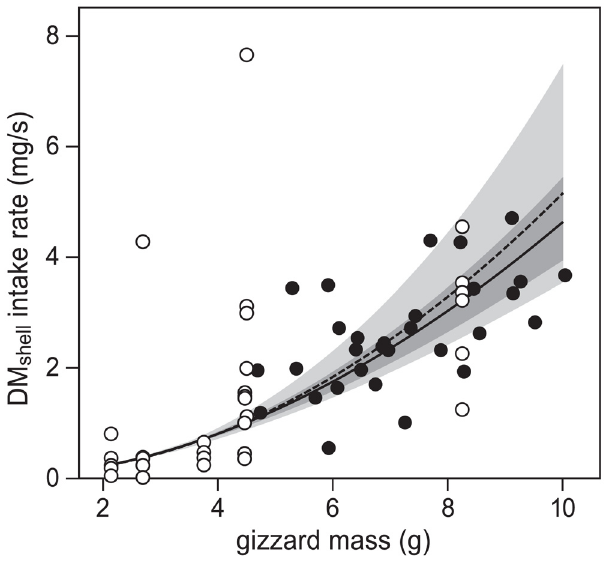
Fig 3. Regression of DM shell intake on non-toxic prey against gizzard mass. Data from this study on Dosinia was combined with data from van Gils et al . [14] on other non-toxic prey species. Adding the current data to the regression derived by van Gils et al . [14] slightly changes the regression line (though not significantly; from dashed to solid line), but greatly reduces standard error (from light to dark grey area). Parameter estimates are shown in S1 Table (model 3.1). Regressions are linear regressions on log- transformed data. Note that van Gils et al . [14] averaged gizzard mass measurements per bird, whereas we estimated gizzard mass in each trial by interpolating